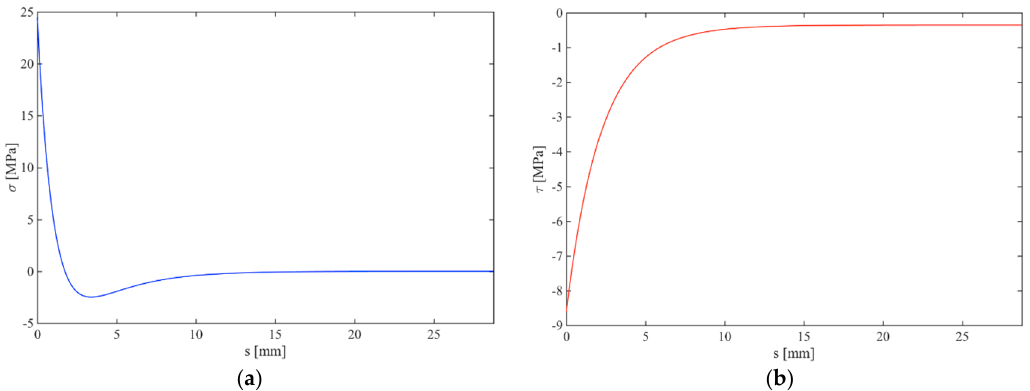
Figure 22. Composite specimen: ( a ) Normal stress; ( b ) Tangential stress.